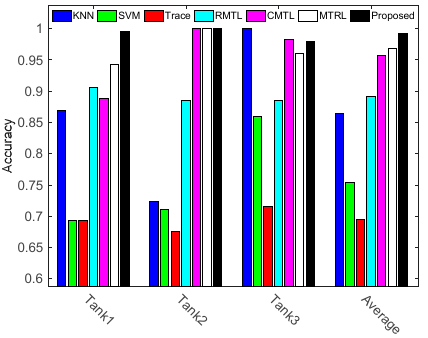
Figure 6. Recognition rates of all the compared methods. Term ‘Average’ denotes the average recognition rate of three tanks. Table 3. Recognition rates of all the compared methods.